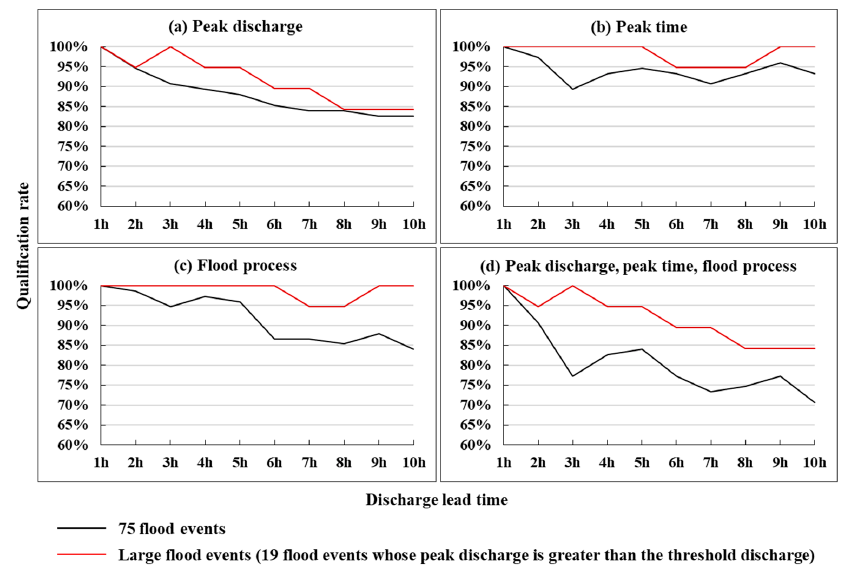
Figure 6. Qualification rate of large flood events and all flood events.